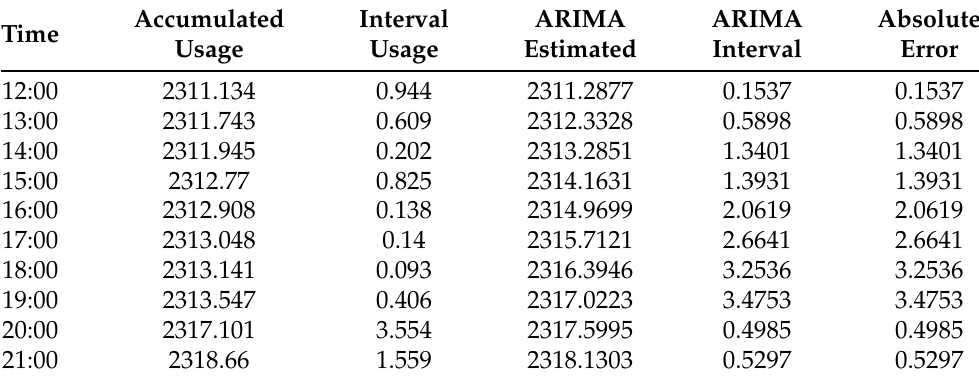
Table 6. Data corrected via the ARIMA-based compensation